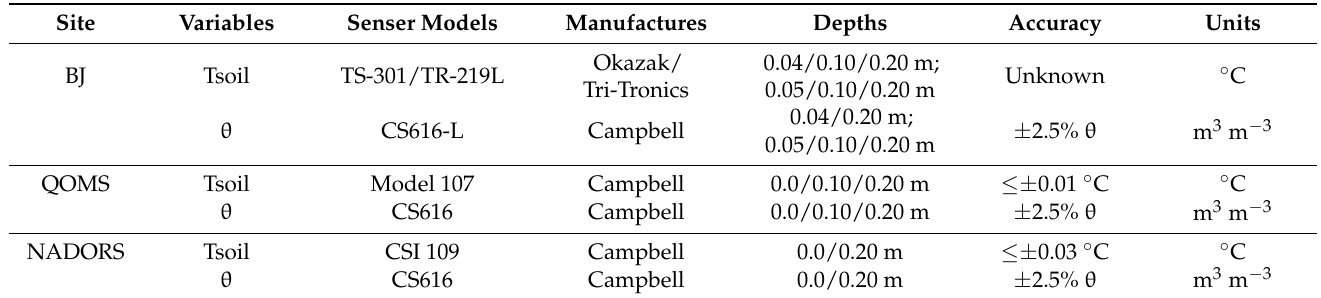
Table 2. The sensors and observation information at each